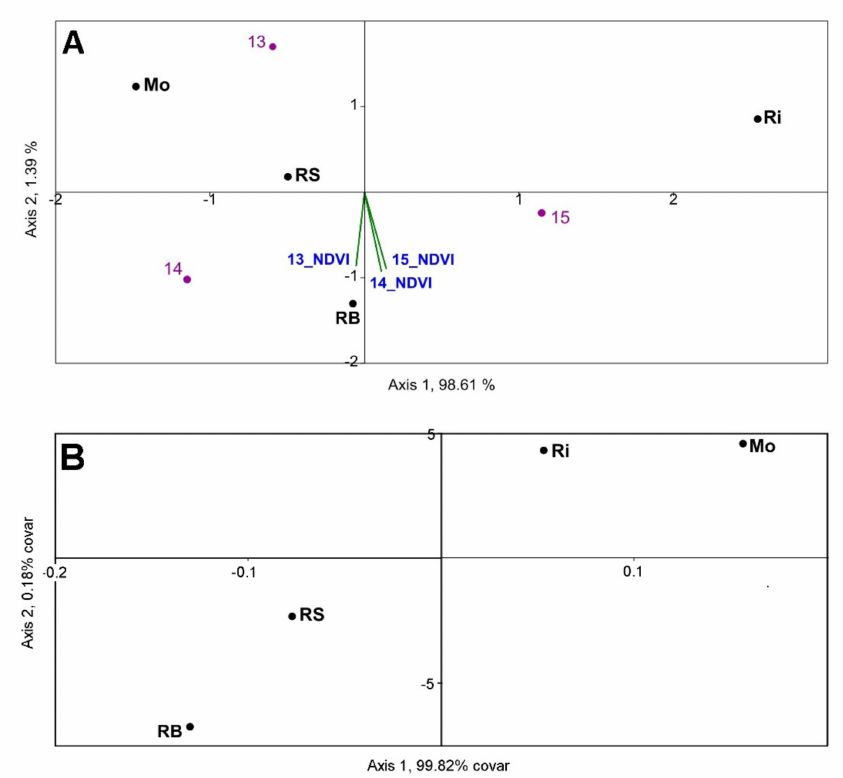
Figure 6. CCA ( A ) and TB-PLS ( B ) of the correlation between NDVI and regional yeast species diversity in the four AOPs during the three consecutive years examined. AOPs: Mo: Monterrei, Ri: Ribeiro, RS: Ribeira Sacra, RB: R í as